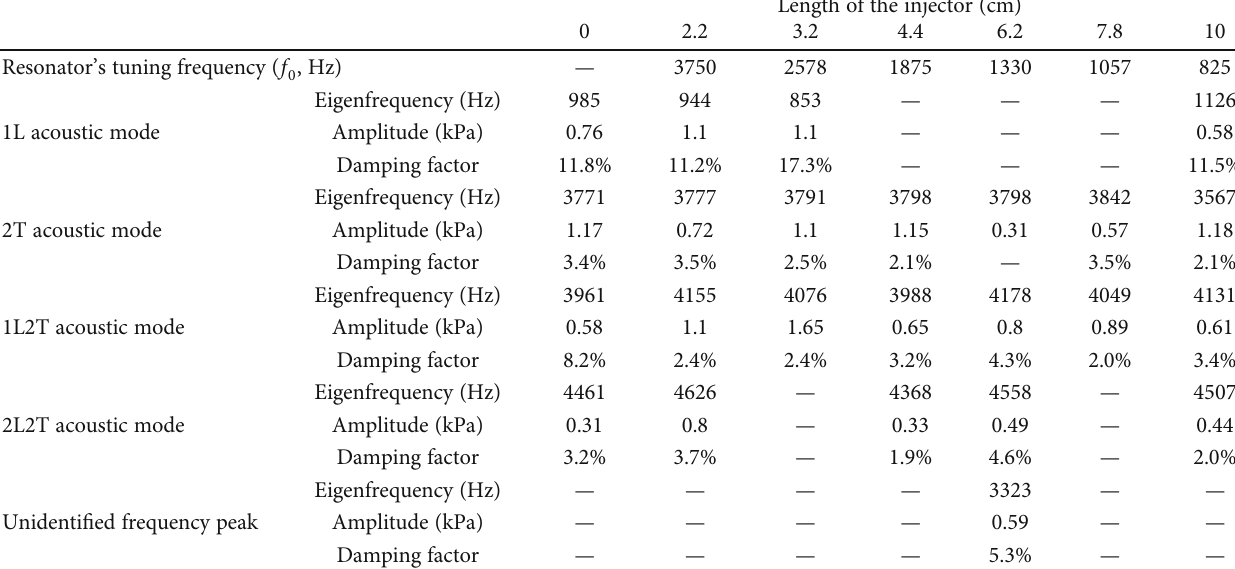
Table 4: Eigenfrequency, power amplitude, and damping rate of acoustic modes in the Model B